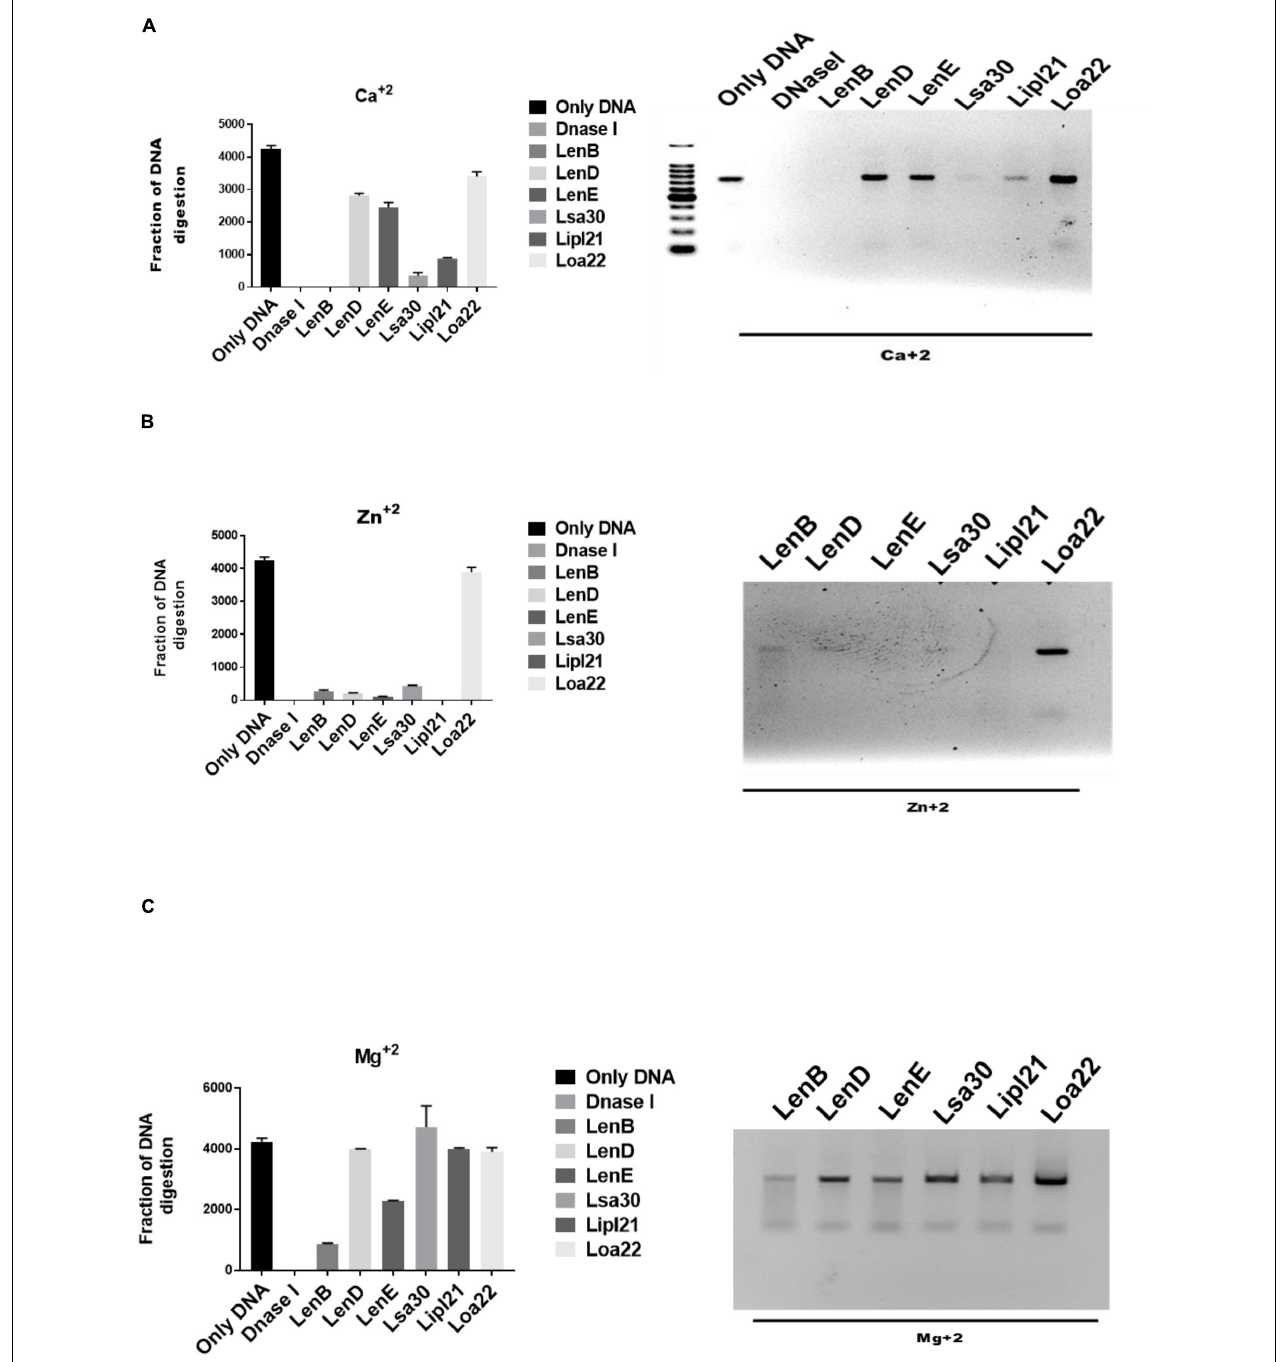
FIGURE 6 | Evaluation of in vitro nuclease activity of surface-exposed lipoproteins. Seven hundred–base pair DNA fragment (200 ng) was incubated with 5 µ g of surface proteins (rLenB, rLenD, rLenE, rLsa30, rLipl21, or rLoa22) or DNase I in DPBS with 5 mM MgCl 2 , CaCl 2 , or ZnCl 2 at 37 ◦ C for 3 h followed by visualization using the Agarose gel electrophoresis. Screening of nuclease activity of surface proteins in presence of (A) calcium chloride, (B) zinc chloride, and (C) magnesium chloride. All data are representative of three different